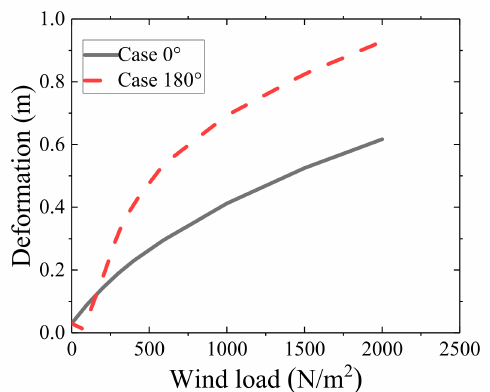
Figure 5. Midspan vertical deformation of the structure as the wind load